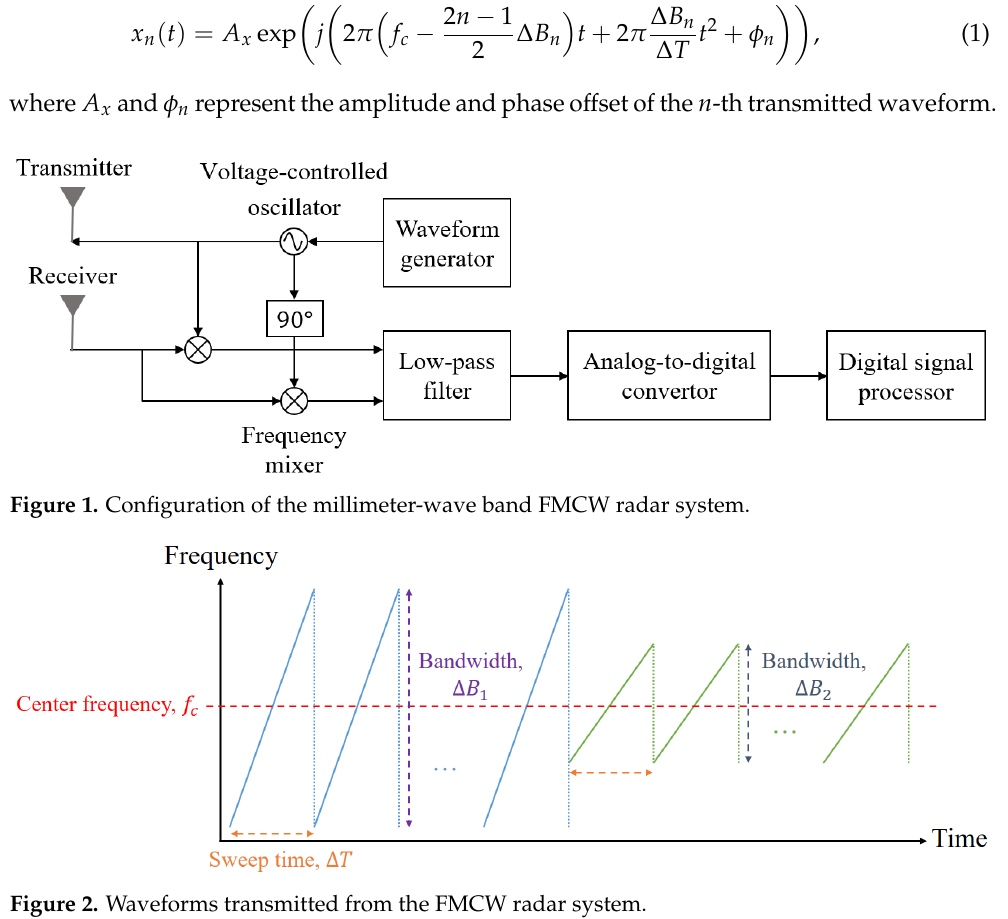
Figure 2. Waveforms transmitted from the FMCW radar system.